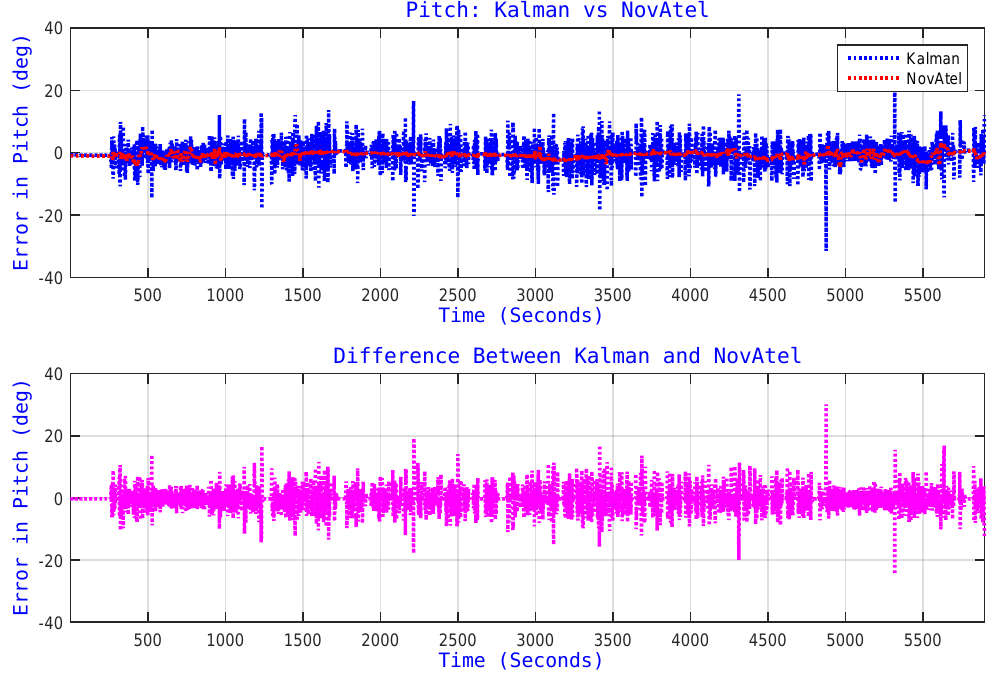
Figure 19. (Top) Performance of estimated pitch angle versus the reference for the Toronto trajectory. The bottom plot shows the difference between the two systems.